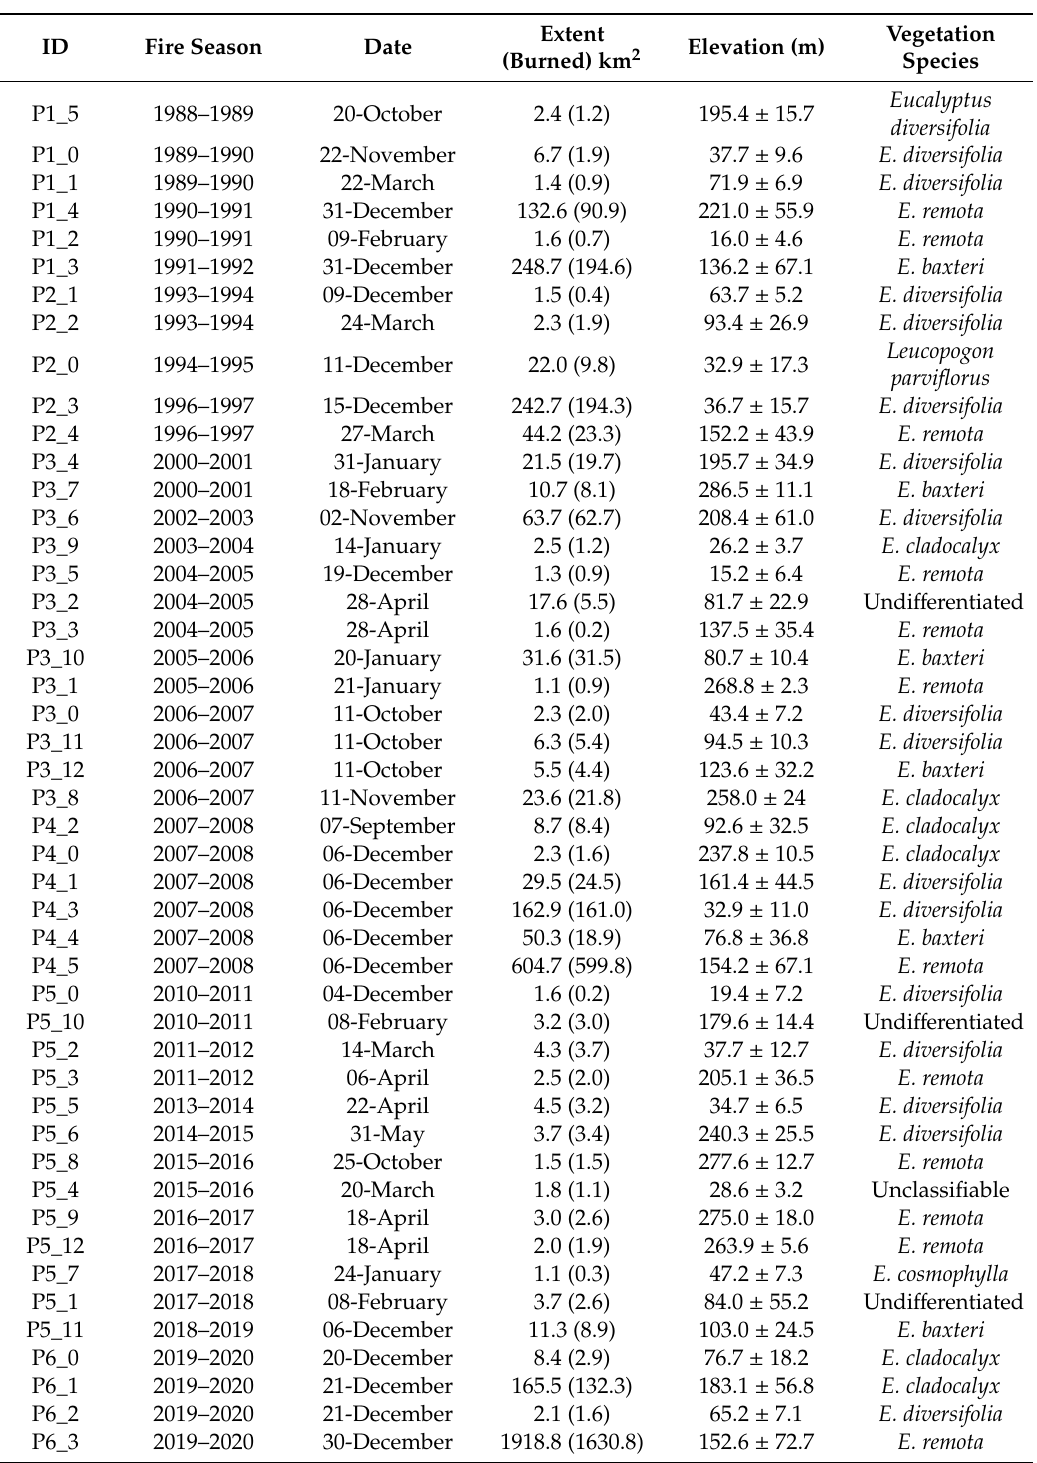
Table 2. Recorded fires on Kangaroo Island [45] from 1988 to 2020 with extent polygons larger than 1 km 2 . Vegetation species determined by the most common National Vegetation Information System (NVIS) 5.1 [42] Level 5–6 vegetation species overlapping burned pixels for each fire. Fires listed in chronological